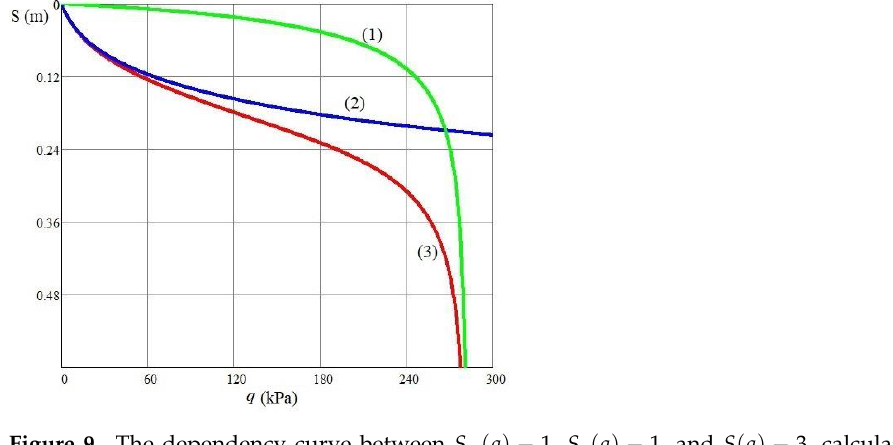
Figure 9. The dependency curve between S γ ( q ) − 1, S v ( q ) − 1, and S ( q ) − 3, calculated using Equation (35), and load q .